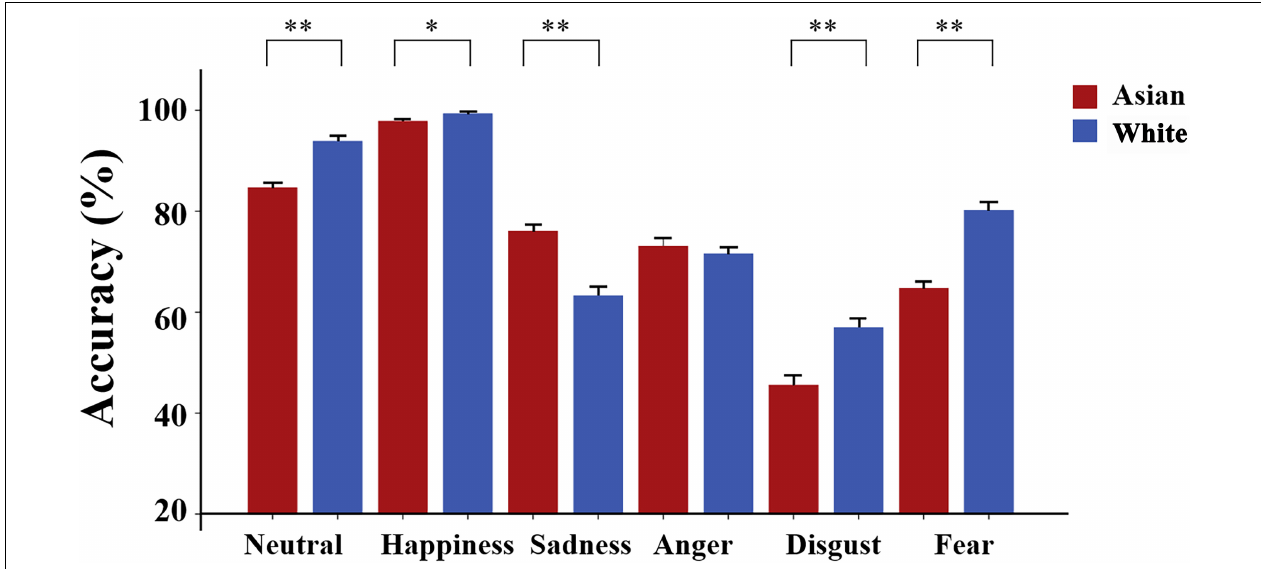
FIGURE 2 | Differences in recognition accuracy for Asian and White expressions. Histograms show mean ± SEM% accuracy. ∗ p < 0.05 and ∗∗ p < 0.01 for Asian vs. White faces.